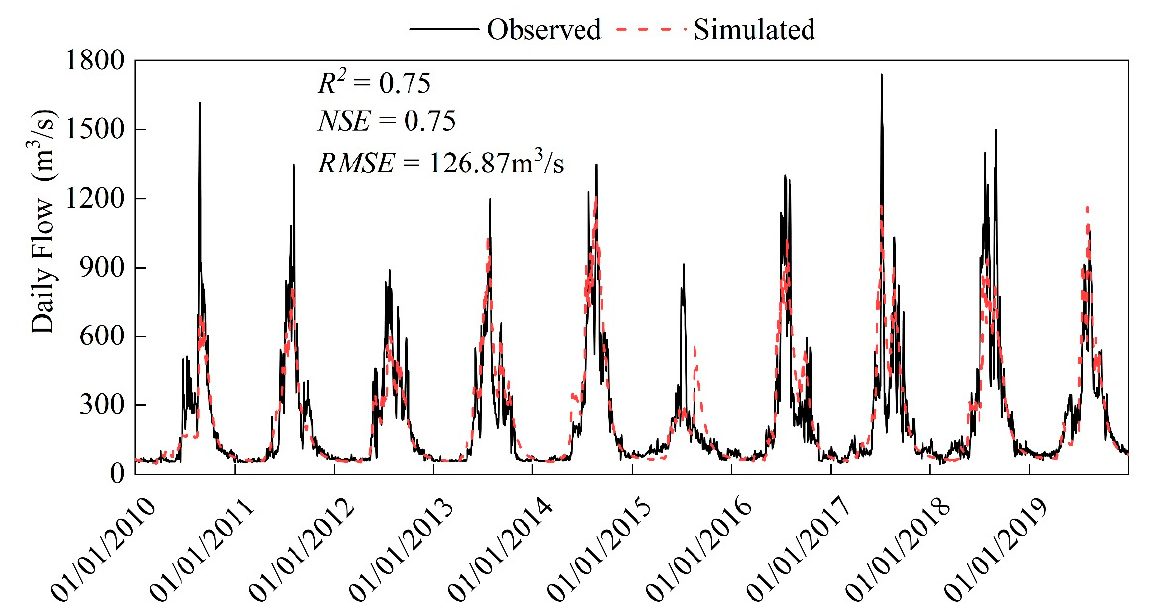
Figure 4. The time series plots between observed and simulated flow at the TANGJIA station.